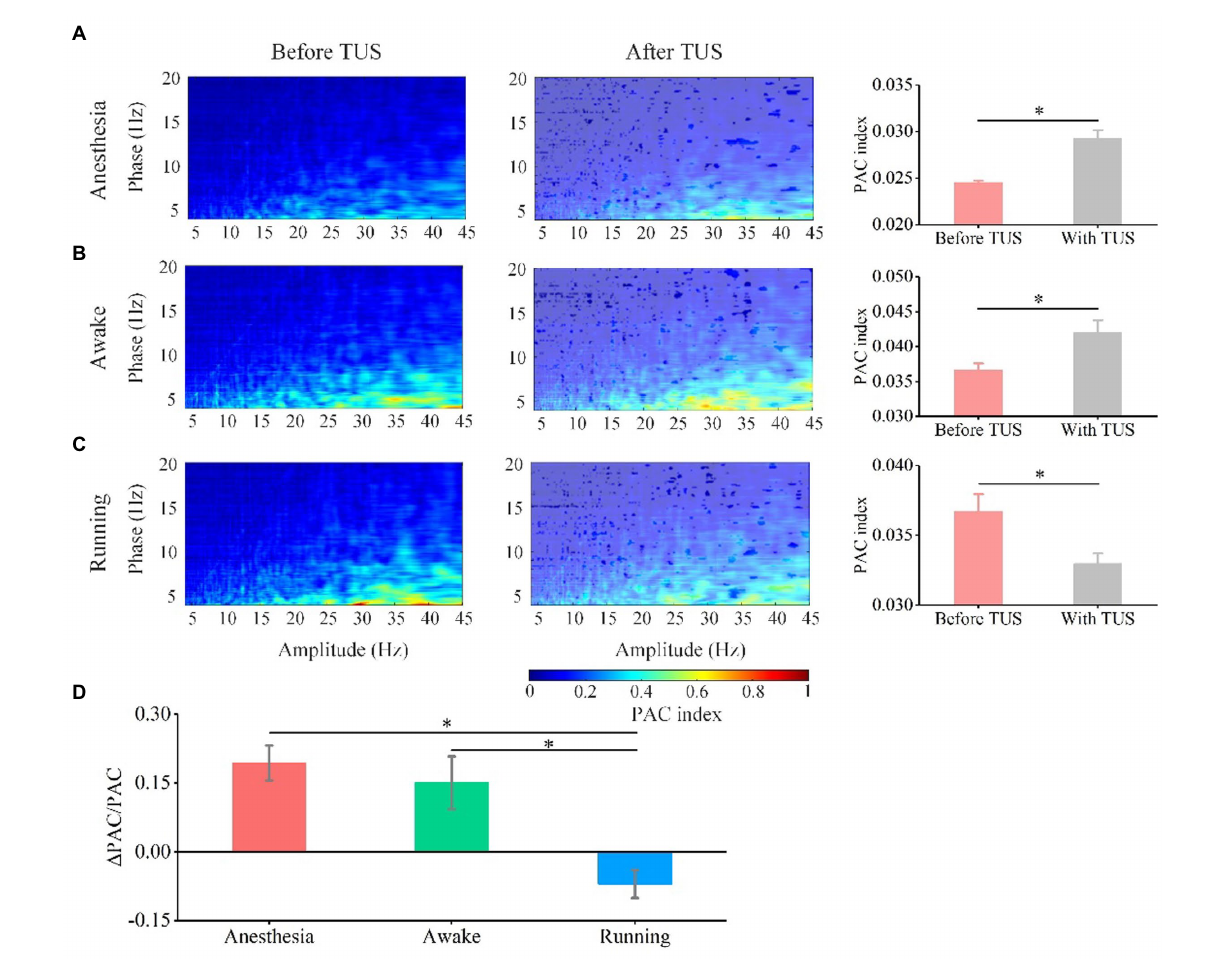
FIGURE 5 Phase-amplitude coupling between theta and gamma oscillation before and with TUS under the anesthesia, awake, and running states. (A) Anesthesia state. (B) Awake state. (C) Running state. (D) Relative change in PAC under the anesthesia, awake state, and running state. ( N = 7 for each state, mean ± SEM, * p < 0.05, Kruskal–Wallis test with post-hoc pairwise